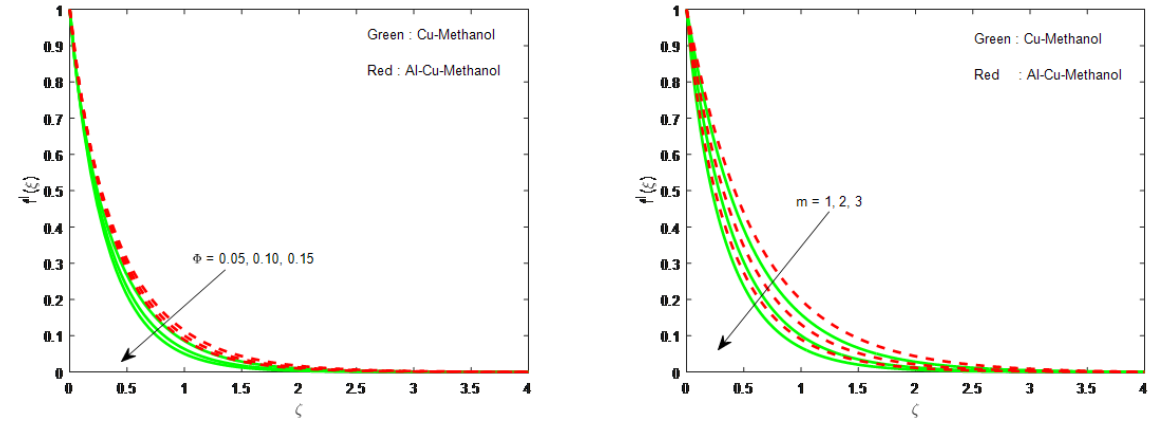
Fig. 17: Impression of Φ on f (cid:48) ( ξ )